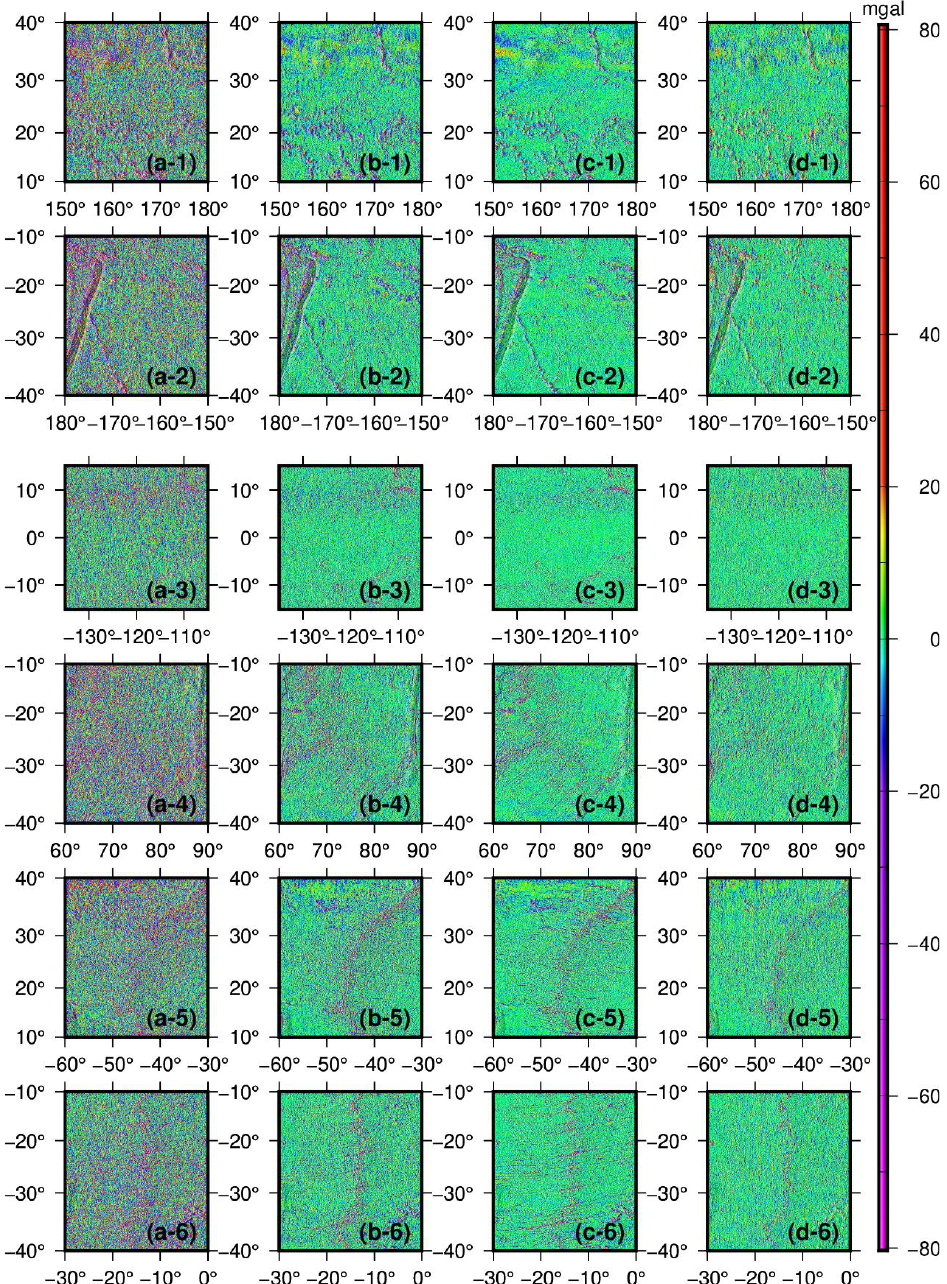
Figure 13. Residual gravity anomaly of GRAHY2, WHU16 and NSOAS22 models in the six study regions and difference between NSOAS22 and WHU16 (the lowercase letters ( a – d ) represent GRAHY2, WHU16, NSOAS22 and difference between NSOAS22 and WHU16; the Arabic numbers ( 1 – 6 ) represent the study regions). To further highlight HY-2 ’ s contribution, the difference between NSOAS22 and WHU16 was also plotted as column d in Figure 13. The difference grid consistently re- flected typical gravity signals in the six study regions, indicating that incorporating HY-2 data was helpful to capture more signals during the marine gravity recovery modeling.